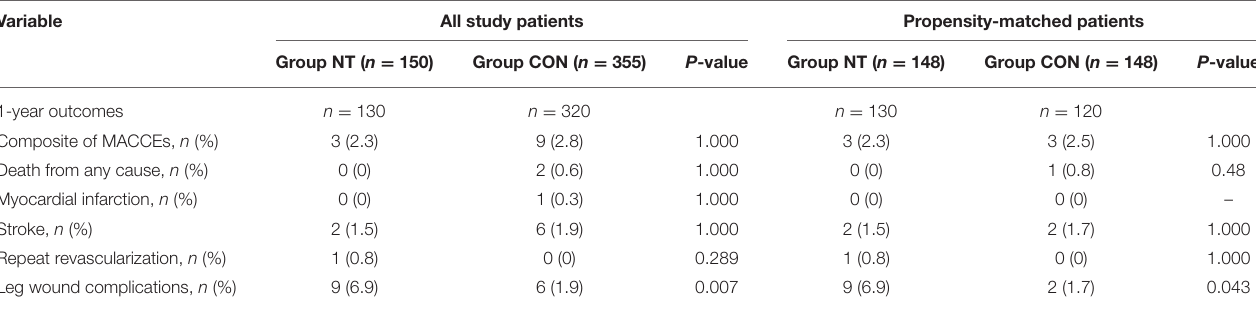
TABLE 4 | Main outcomes and adverse event at 1-year.